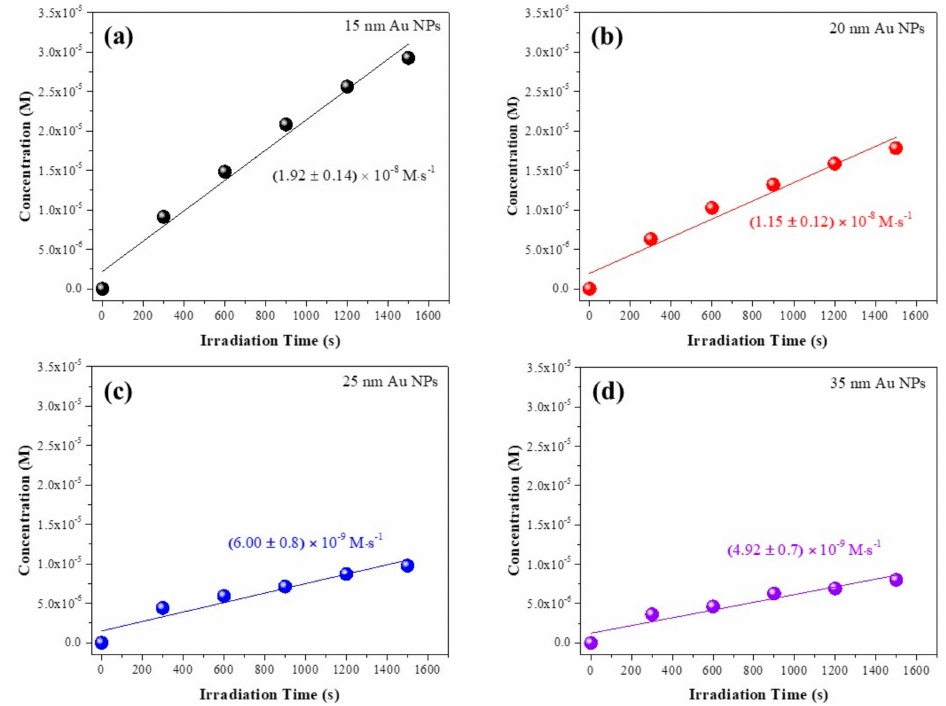
Figure 3. Au-catalyzed photochemical reaction under 532 nm light excitation with a power of 700 mW. Concentration (M) as a function of irradiation time for ( a ) 15 nm, ( b ) 20 nm, ( c ) 25 nm, and ( d ) 35 nm Au NPs. The values in each figure are reaction rates determined by linear fitting for each